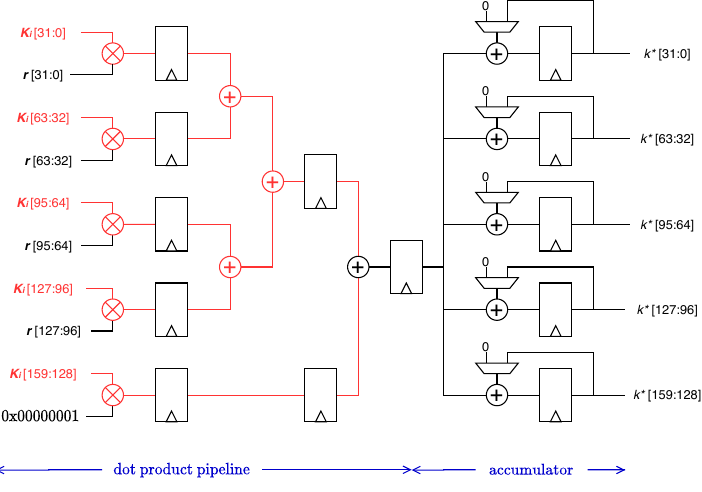
Figure 6: Architecture of the dot product